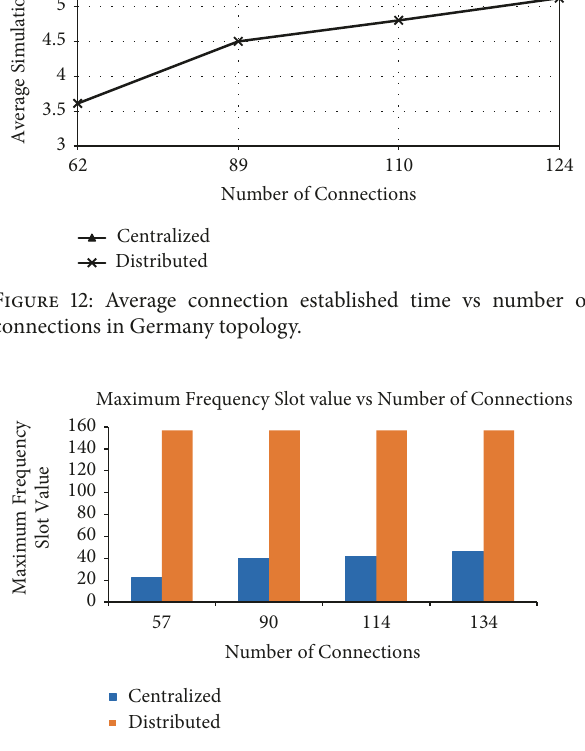
Figure 13: Max frequency slot value vs number of connections in Finland topology.